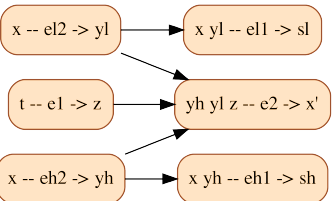
Figure 6. DG resulting from the approximate structural analysis of the Water Tank model. Vertices are labeled following the same rules as for Figure 2. Edges express causal dependencies, meaning that a block can be solved only after all its predecessors have been solved.